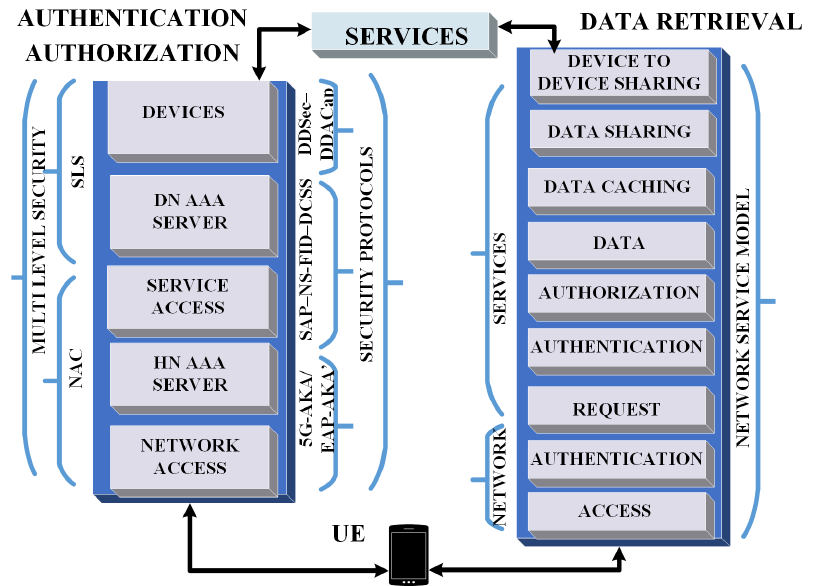
Figure 4. Security